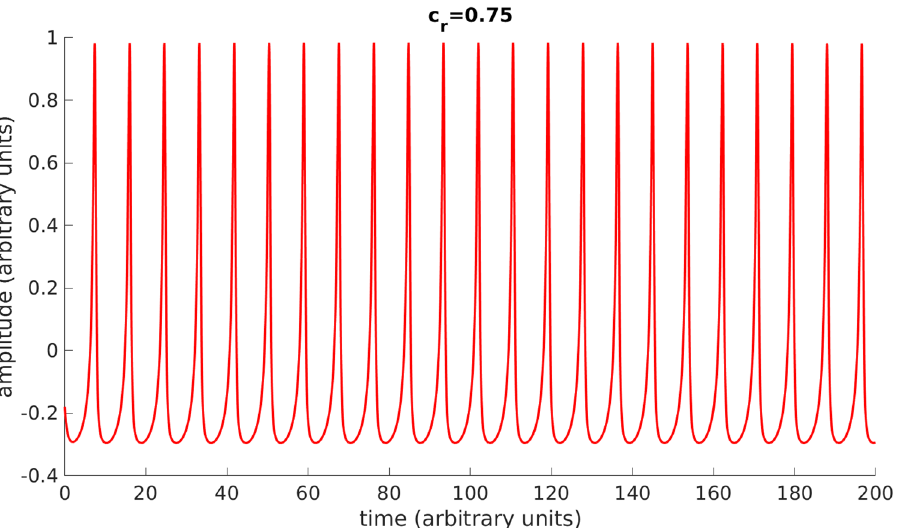
Figure 9. The amplitude and phase of a single mode for c r = 0.75 .